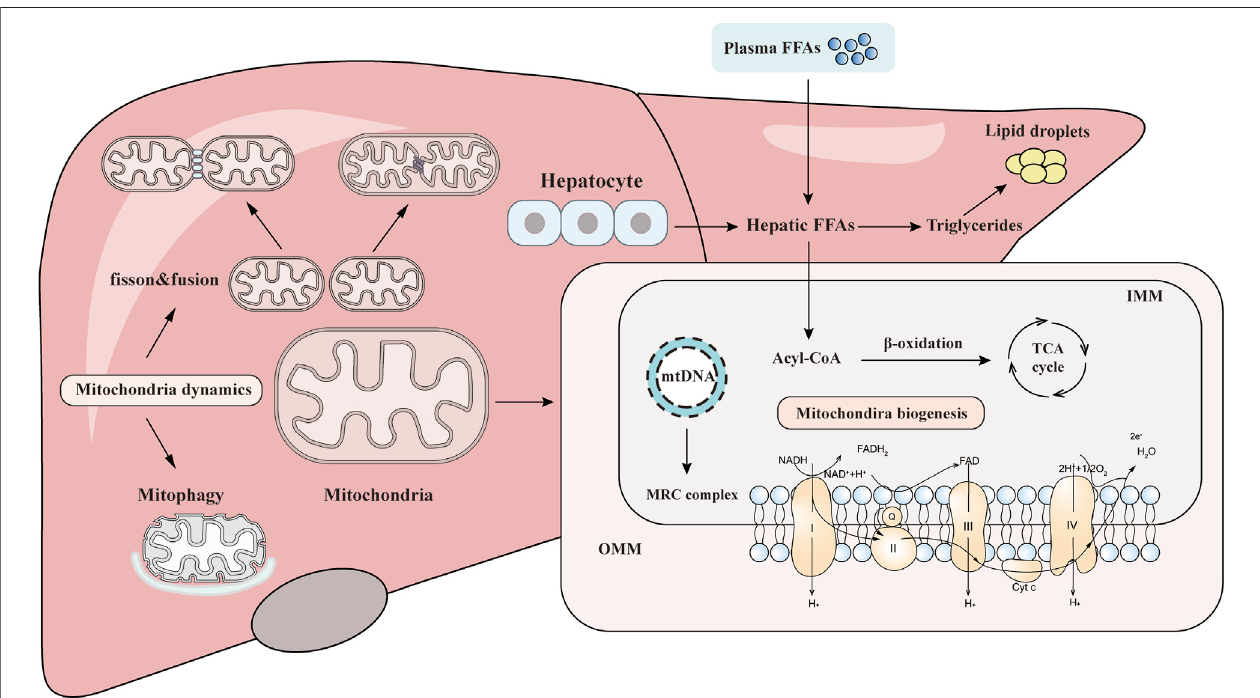
FIGURE 1 | Overview of the association between mitochondrial homeostasis and NAFLD. Mitochondria are dynamic and complex organelles, and their homeostasis is mainly maintained by the balance of mitochondrial biogenesis, mitochondrial fi ssion/fusion, and mitophagy. Mitochondrial injury can aggravate the hepatic lipid accumulation and ROS production and induce the in fl ammation and fi brosis that contribute to the pathogenesis and progression of NAFLD.